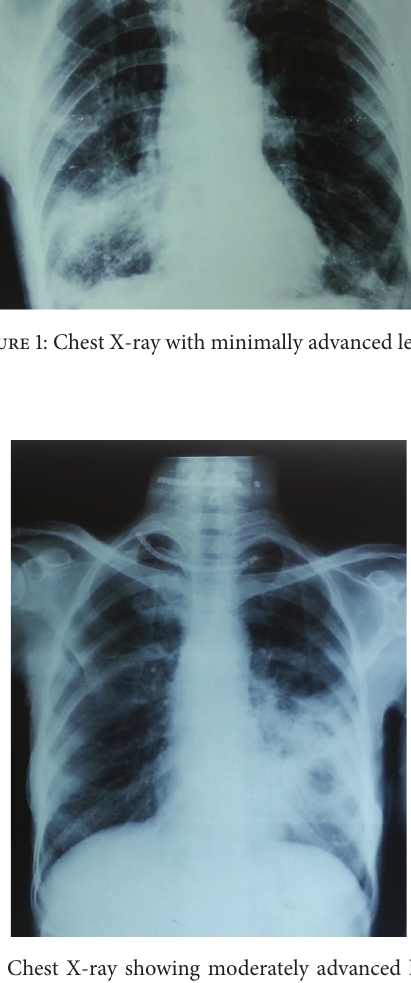
Figure 2: Chest X-ray showing moderately advanced lesion with cavity less than 4cm in diameter.